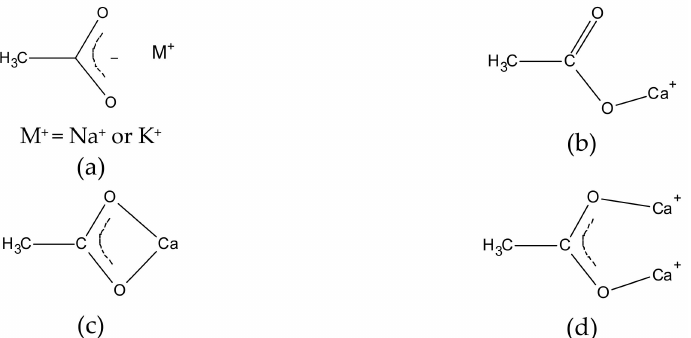
Figure 4. Chemical structures of metal carboxylates. ( a ) Ionic form of monovalent metal ions; ( b ) unidentate coordination; ( c ) chelating bidentate coordination; and ( d ) bridging bidentate coordination to calcium ions. Structures adapted from